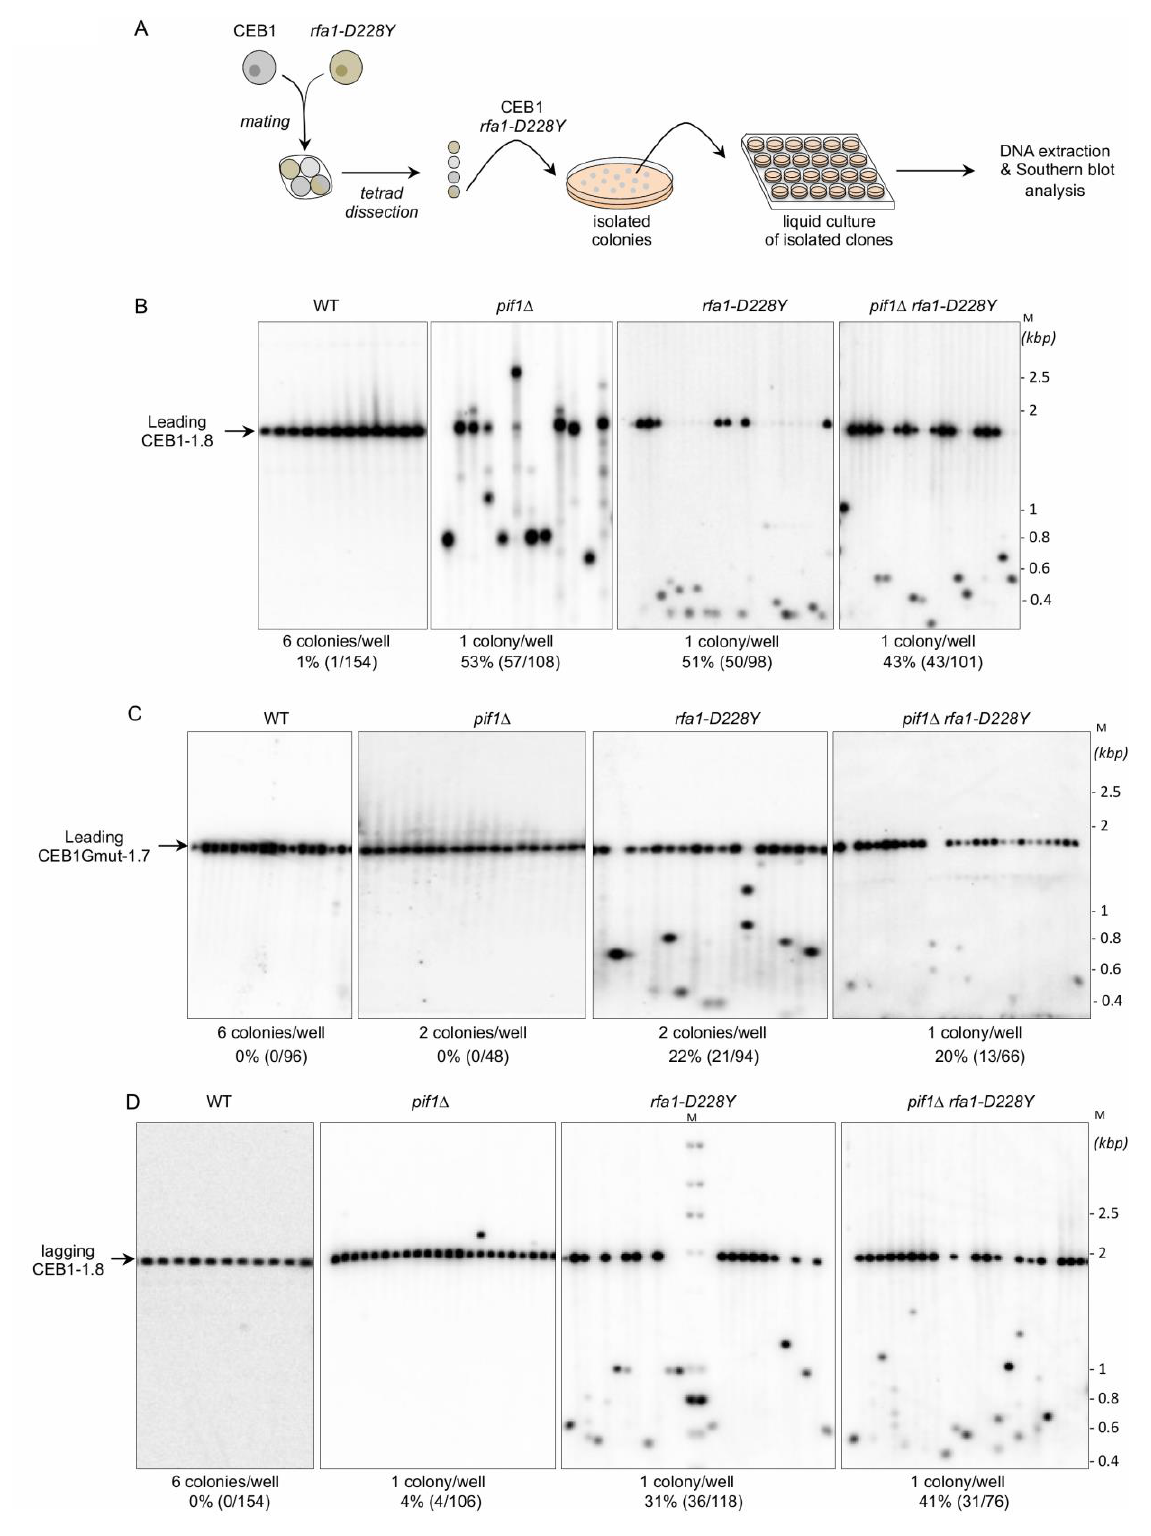
FIGURE 2: RPA is required to stabilize CEB1. (A) Experimental scheme. Yeast strains of interest are mated and the resulting diploid sporulated and dissected. After identification of spore-colonies of interest, the spore-colony is plated on media to obtain isolated colonies. Individual colonies are placed in liquid culture until stationary growth phase. Genomic DNAs are extracted and analysed by Southern blot. (B) RPA is required to stabilize CEB1 when the G4-forming strand is replicated by the leading polymerase. Genomic DNAs from yeast cells bearing the leading-CEB1 were digested by Apa I and Xho I, and southern blotted. Mem- branes were hybridized with the CEB1-0.6 probe. (C) Genomic DNAs from yeast cells containing the leading-CEB1Gmut-1.7 were digested by Apa I and Sac II, and southern blotted. The membranes were hybridized with the CEB1Gmut-1.7 probe. (D) In contrast to Pif1, RPA is required to stabilize CEB1 when the G4-forming strand is replicated by the lagging polymerase. Genomic DNAs from yeast cells bearing the lagging-CEB1 were digested by Apa I and Nco I, and southern blotted. Membranes were hybridized with the CEB1-0.6 probe. M: ladder DNA serving as size standard (kbp). The number of colonies analysed per well, the percentage of rearrangement frequencies, and the total numbers of colonies are indicated in Table